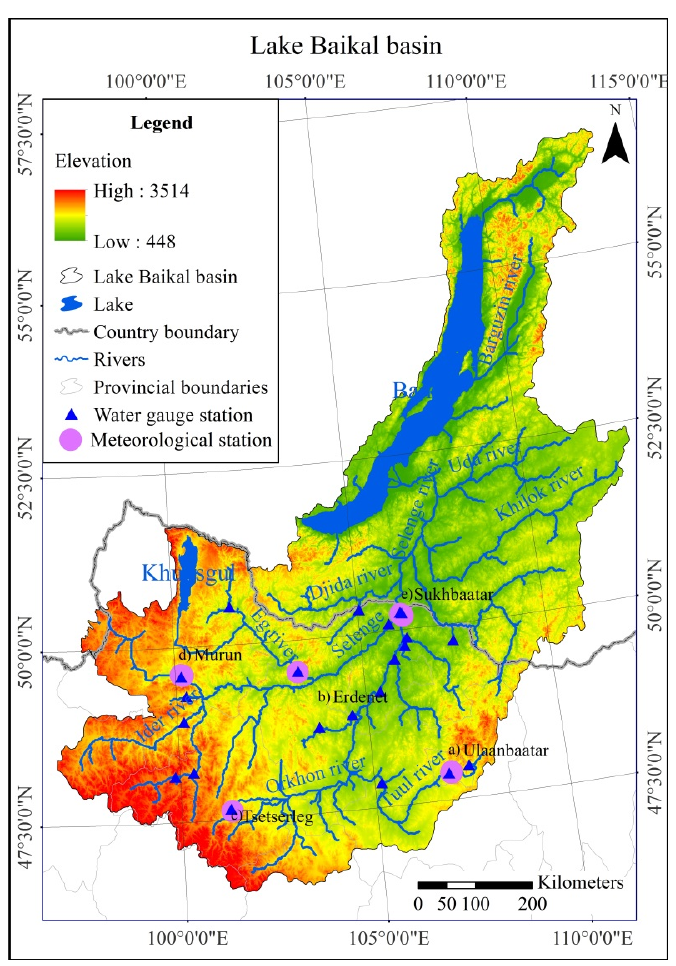
Figure 1. Location of Lake Baikal basin (LBB), Water gauge station and meteorological stations of the Selenga River basin located in the Mongolian.